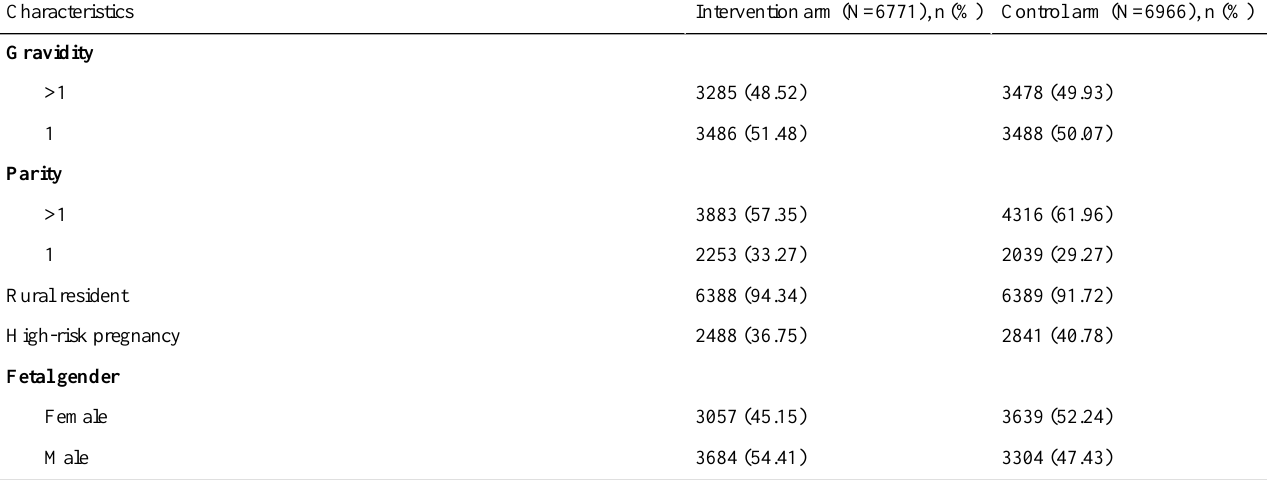
Table 1. Comparison of maternal and infant characteristics between the intervention and control arms at the individual level, Hunan, China,